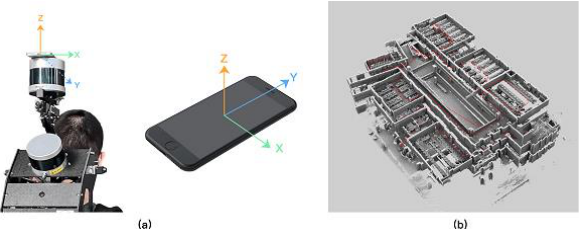
Figure 4. Illustration of the indoor positioning dataset. (a)Setup of the smartphone with XBeibao. (b)SLAM trajectory as synchronized reference for indoor